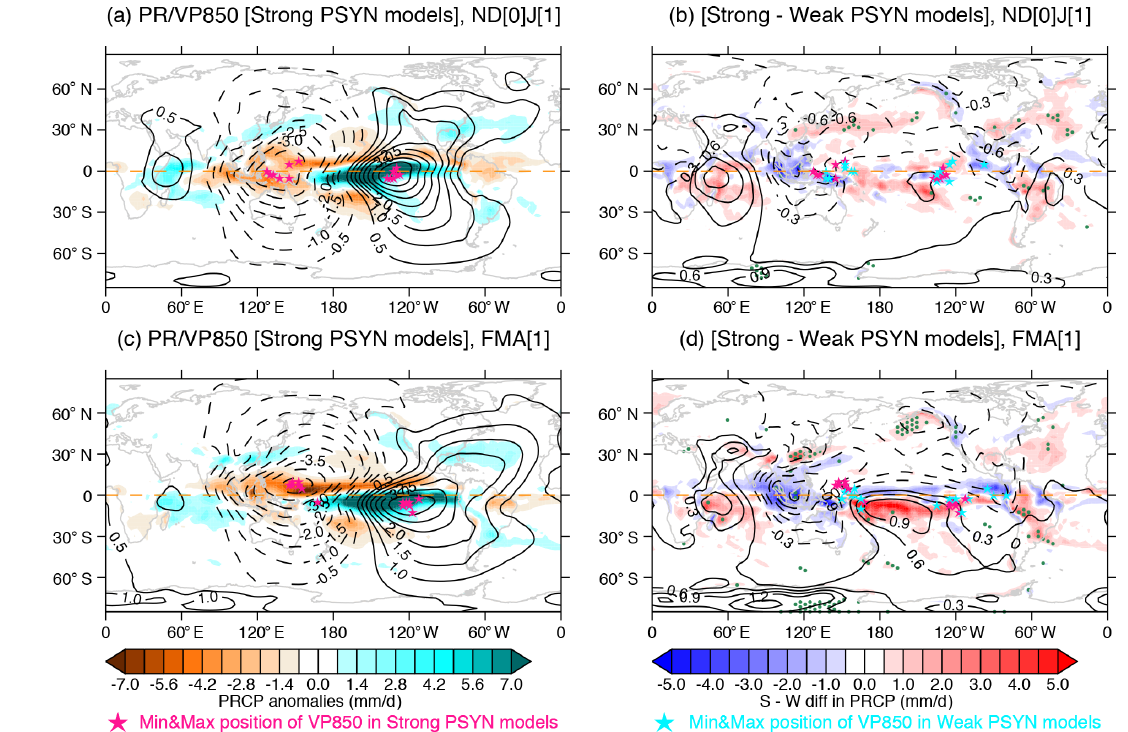
Figure 5. Impact of phase-synchronized spatial shifts of the HC and WC on global precipitation. (a) The November–December[0]– January[1] extreme El Niño (i.e., 1982/1983 and 1997/1998) composite anomaly of precipitation (shading) and 850hPa velocity potential (VP850; contours) obtained from the eight strong PSYN models in the AMIP simulations and (b) the difference between eight strong PSYN models and eight weak PSYN models. (c, d) Same as (a, b) , but for February–March–April (FMA[1]). The green dots in (b, d) indicate the area where the precipitation difference is statistically significant at the 99% confidence level. The pink and cyan star symbols indicate the positions of maximum and minimum VP850 anomalies for the strong PSYN and weak PSYN models. Here, the strong PSYN and weak PSYN model groups are categorized according to interannual correlation coefficients between WC2 and HC1 within 19 AMIP5 and 21 AMIP6 models, respectively (see Tables 2 and